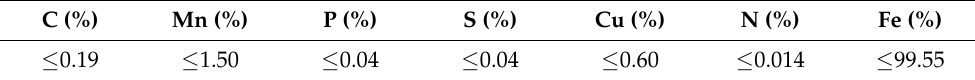
Table 2. Indicative chemical composition of S235J0 steel.